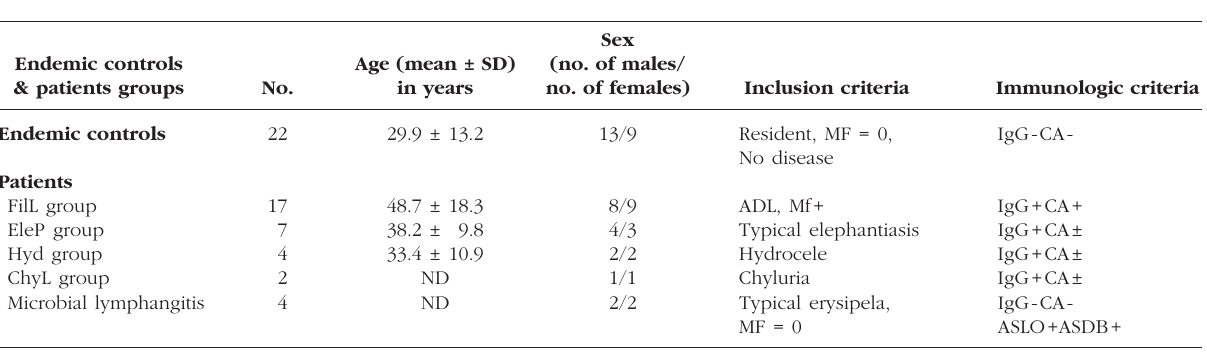
Table I. – Clinical patients and endemic controls included in the fibrosis